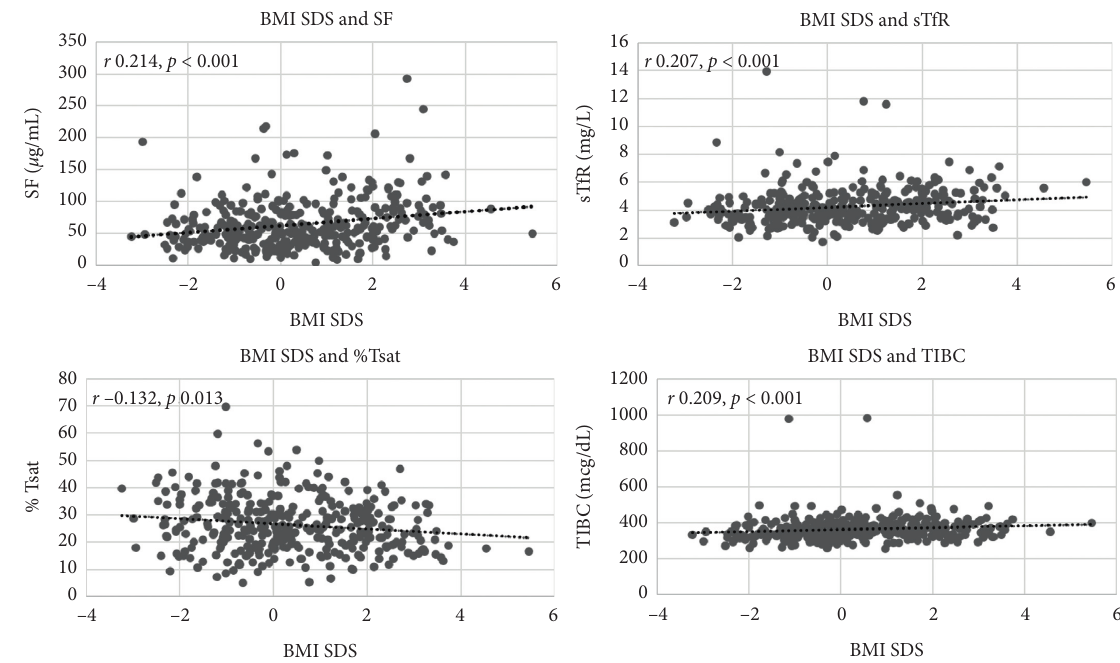
Figure 1: Associations between BMI SDS and SF, %Tsat, and sTfR in 6–12-year-old Thai children ( n �